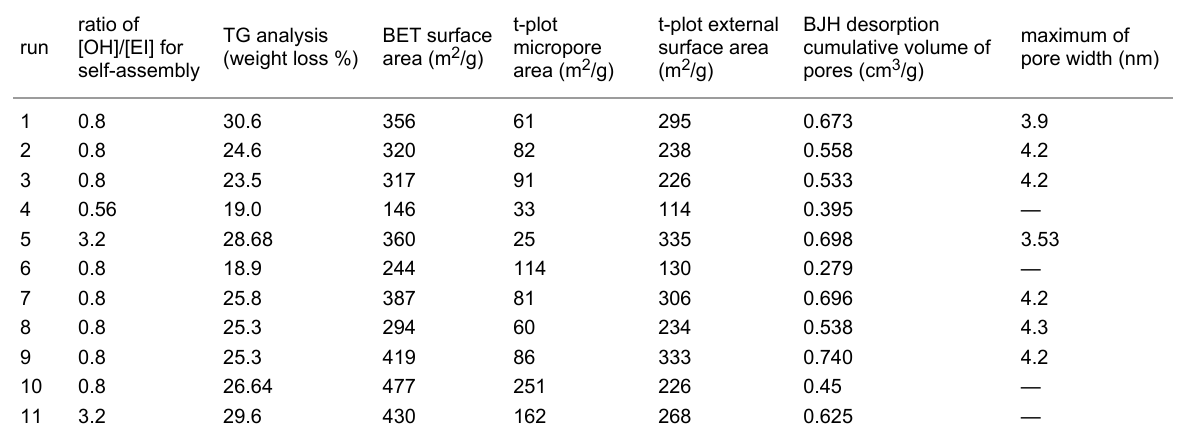
Table 1: Summary of the molar ratios of [OH]/[EI] for the synthesis of the LPEI templates, the TGA analysis of the composition of LPEI@silica hybrid nanostructures and BET data of the silica nanostructures obtained by calcination of LPEI@silica hybrid at 800 °C at air. a